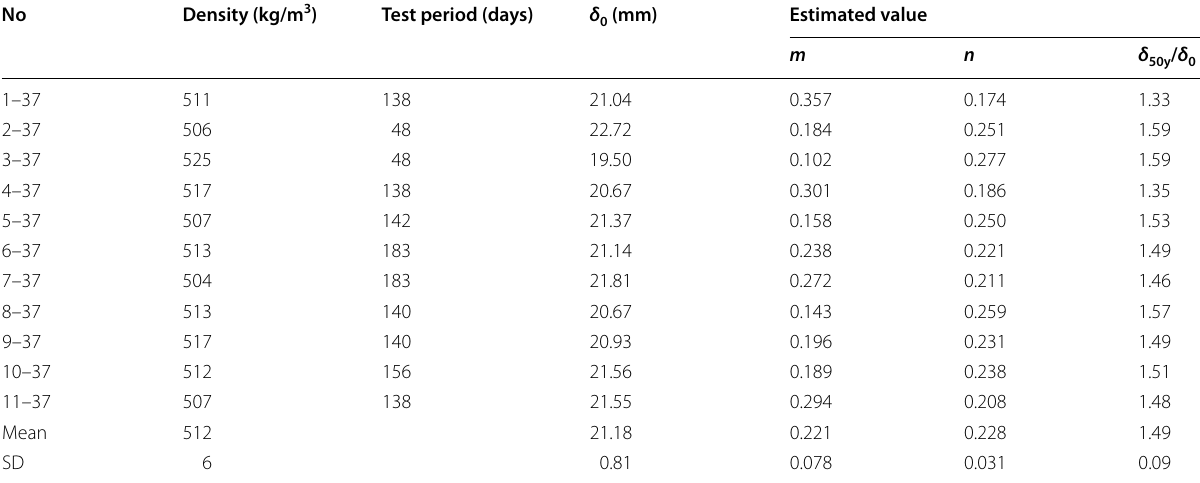
δ 0 is initial deflection, δ 50y is predicted deflection after 50 years, m and n are constants (see Eq. 4), and SD is the standard deviation